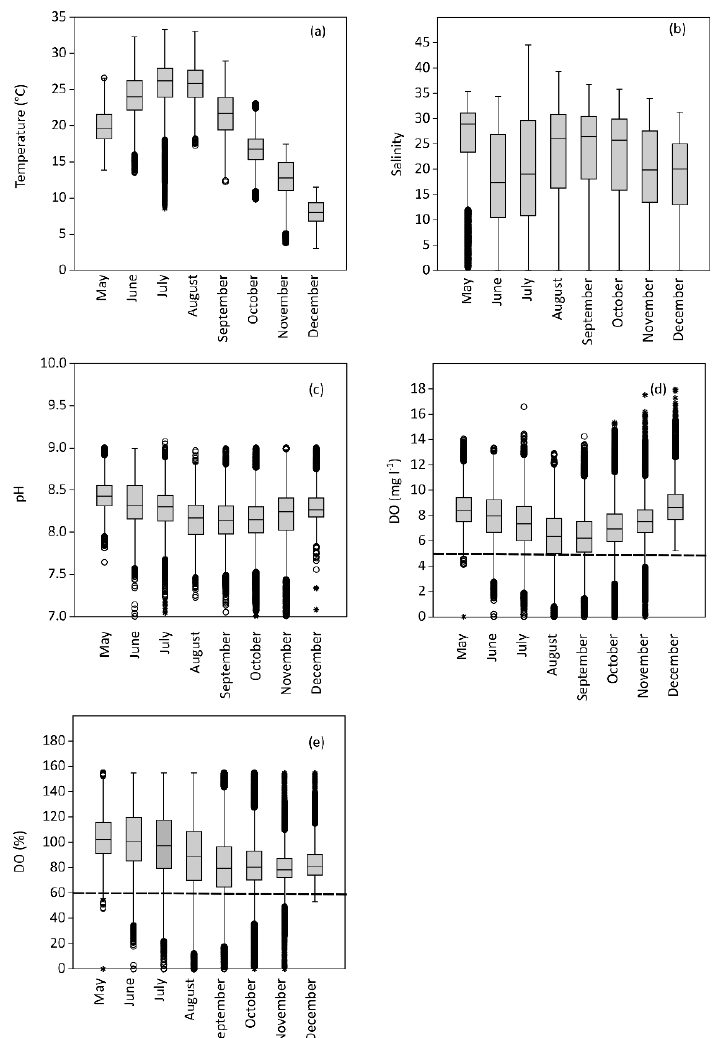
Figure 4. Boxplot representation of seasonal variability of the measured parameters: ( a ) temperature (°C), ( b ) salinity, ( c ) pH, ( d ) DO (mg L −1 ), DO (%). The dashed line in ( d ) and ( e ) represents the limit for sensitive species of fish and invertebrates and the minimum imperative standard required by the EC Shellfish Waters Directive, respectively [59]. In this representation, the presence of outliers is shown as circles if values are 1.5 times out of the box and as stars for values which are 3 times out of the box. Salinity ranged from 1.1 to 39.9 (21.8 ± 9.3; median = 24.1; N observations = 205,533) and is strongly influenced by the amount of freshwater inputs that, in the westernmost part of the lagoon, is related to the degree of precipitation occurring inland, and to a lesser